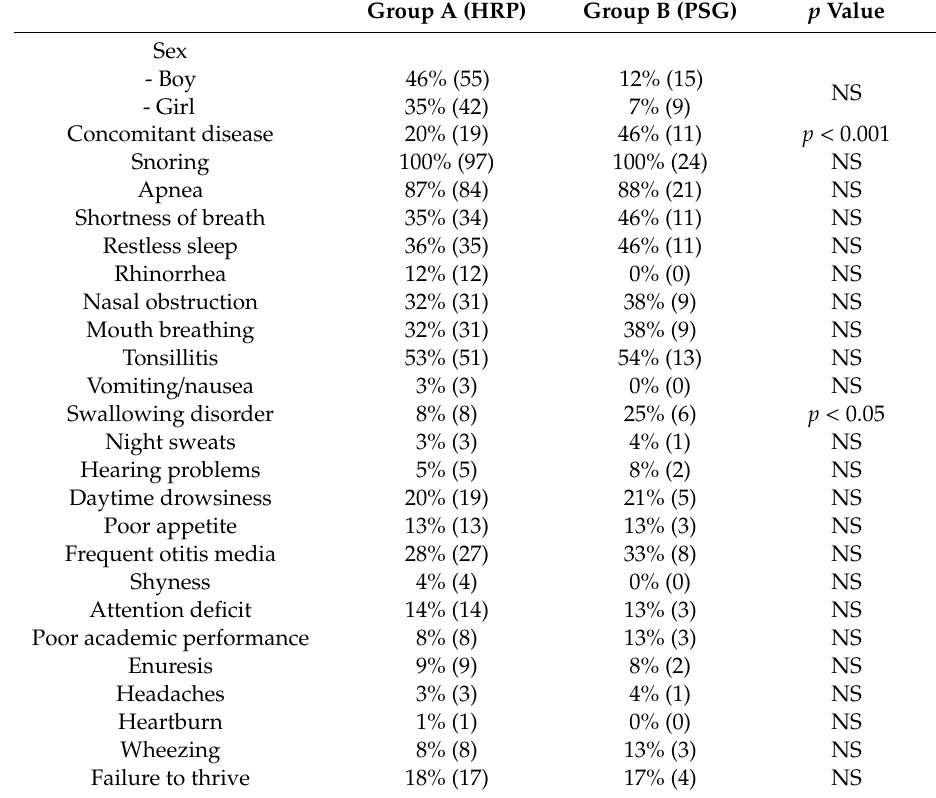
Table 3. Clinical and anthropometric characteristics by